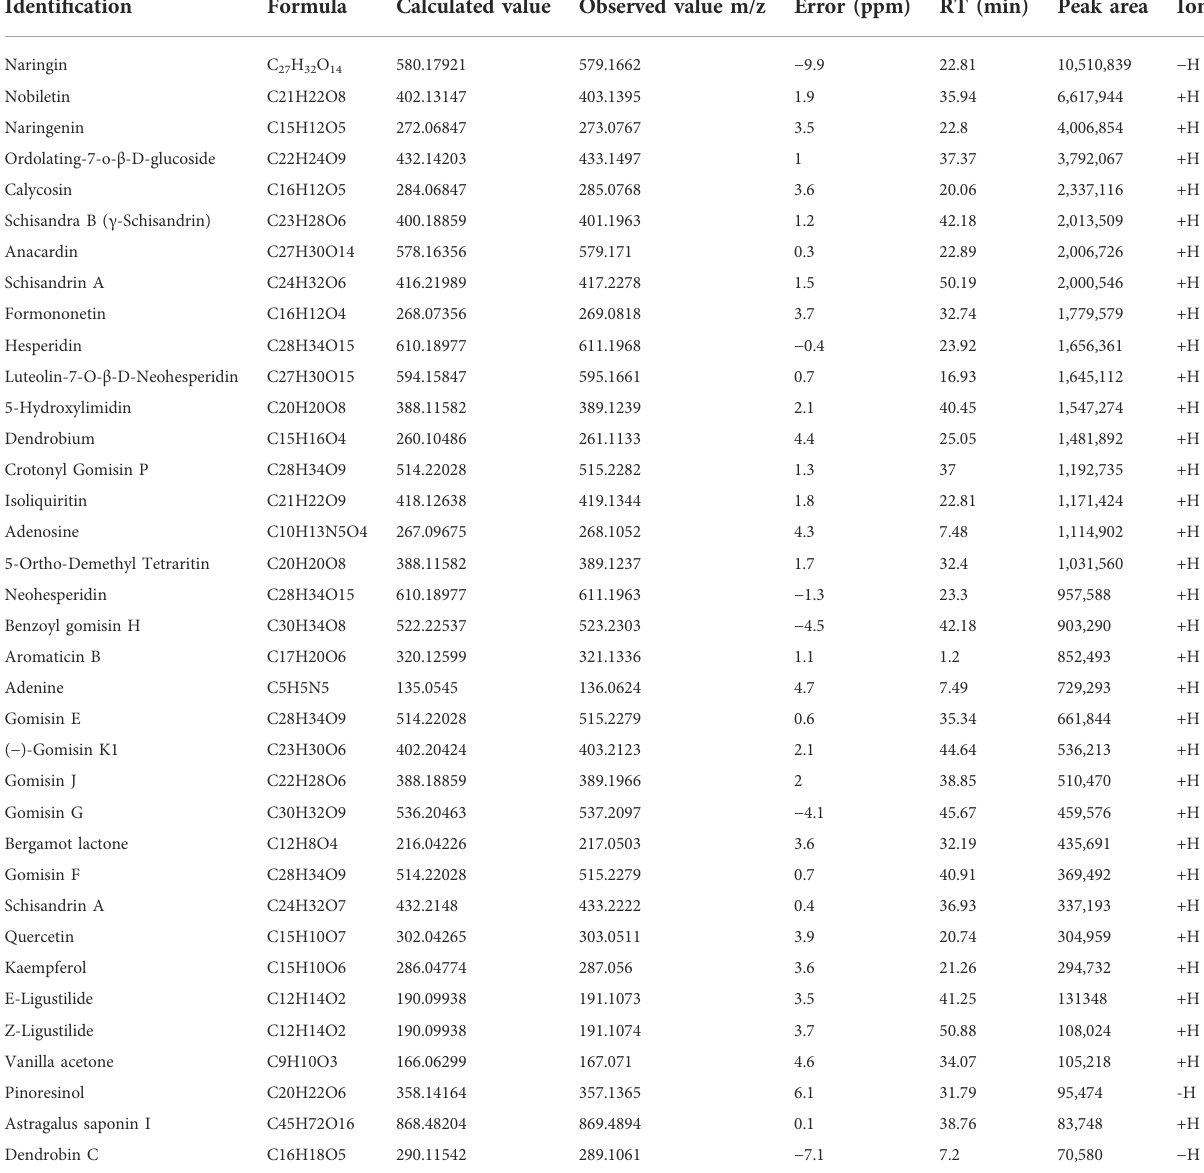
TABLE 2 Analysis of the main chemical constituents of KPLD by UHPLC-MS/MS in positive and negative ion modes. Identi fi